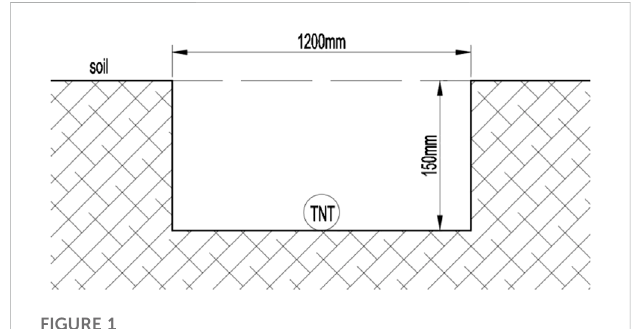
Pro fi le of the three-dimensional fi gure (mm).